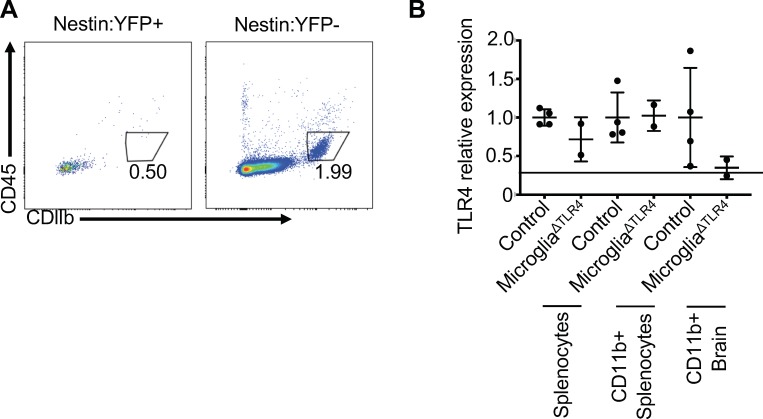
TLR4 signals within microglial cells to limit morbidity in response to JHMV infection of the CNS.(A) Brains from R26R-EYFP; nestin-Cre mice were gated on YFP+ (left) or YFP- (right) populations and microglial markers displayed. (B) qPCR of TLR4 from unpurified splenocytes, CD11b+ MACS purified splenocytes, and CD11b+ MACS purified brain cells of tamoxifen-treated control (TLR4-fl/fl) and microglialΔTLR4 (CX3CR1CreER); TLR4-fl/fl) mice. Data represented as mean ± SEM. Means are calculated from biological replicates.